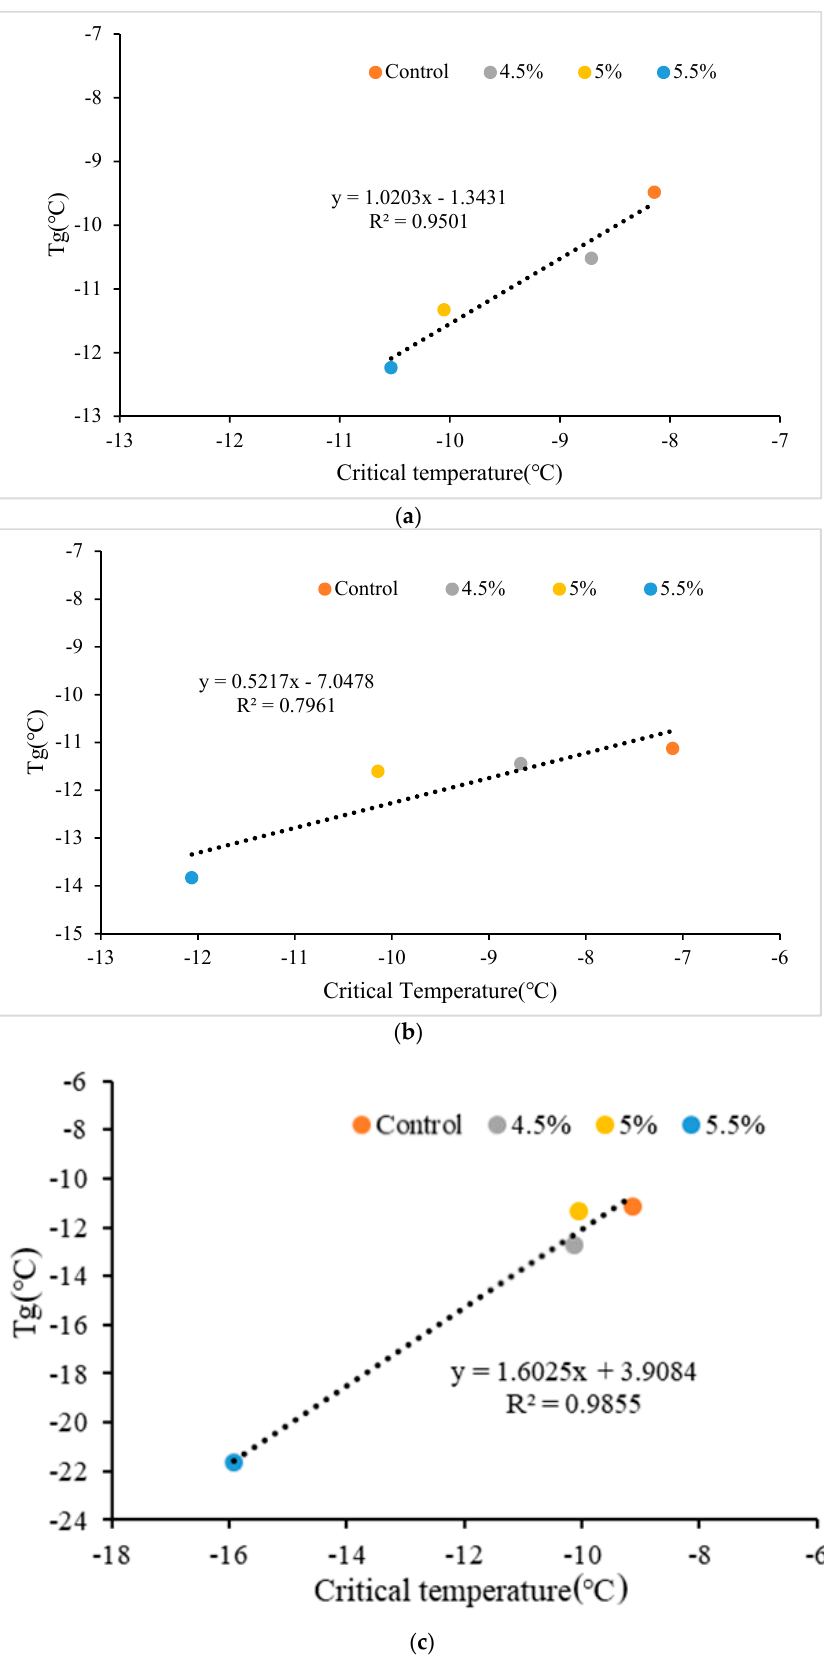
of the three kinds of SBS mod- g